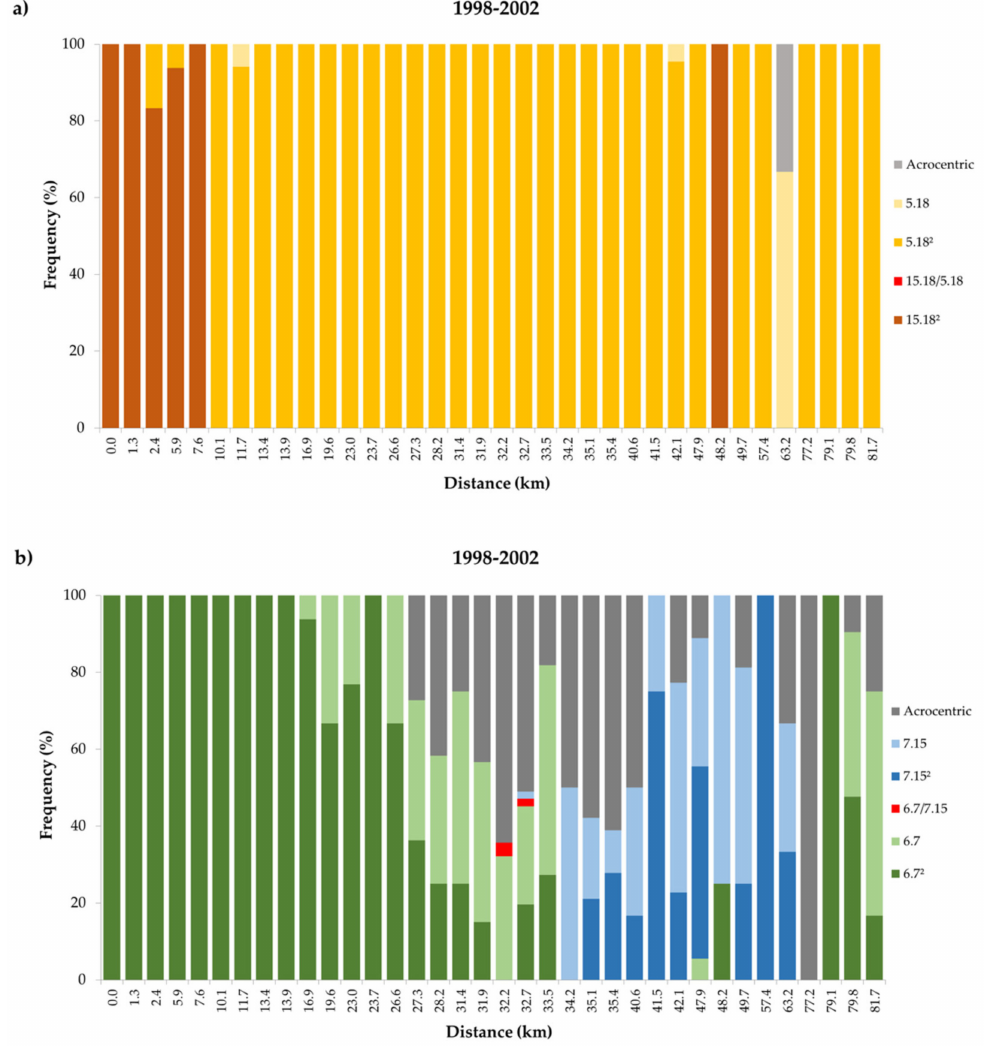
Figure 3. Frequency of diagnostic chromosomal fusions for the period 1998–2002. a) the upper panel shows frequencies of fusions Rb (15.18) and Rb (5.18) in homozygous [(15.18) 2 ; (5.18) 2 ] and heterozygous [(5.18)] states, frequency of hybrid mice carrying both fusions [(5.18) / (15.18)] and frequencies of mice carrying none of the fusions (Acrocentric). b) the lower panel shows frequencies of fusions Rb (6.7) and Rb (7.15) in homozygous [(6.7) 2 ; (7.15) 2 ] and heterozygous [(6.7); (7.15)] states, frequency of hybrid mice carrying both fusions [(6.7) / (7.15)] and frequencies of mice carrying none of the fusions